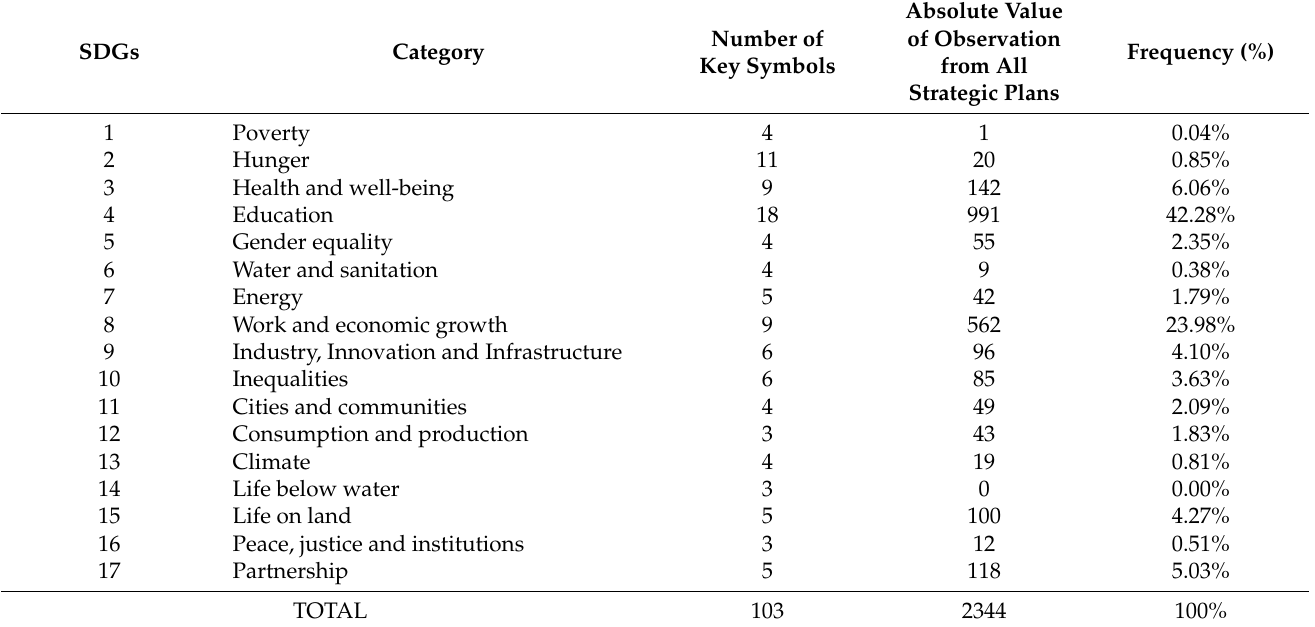
Table 3 highlights what has been disclosed in terms of categories and key symbols. Table 3. Content Analysis results for individual category. Source: Author’s